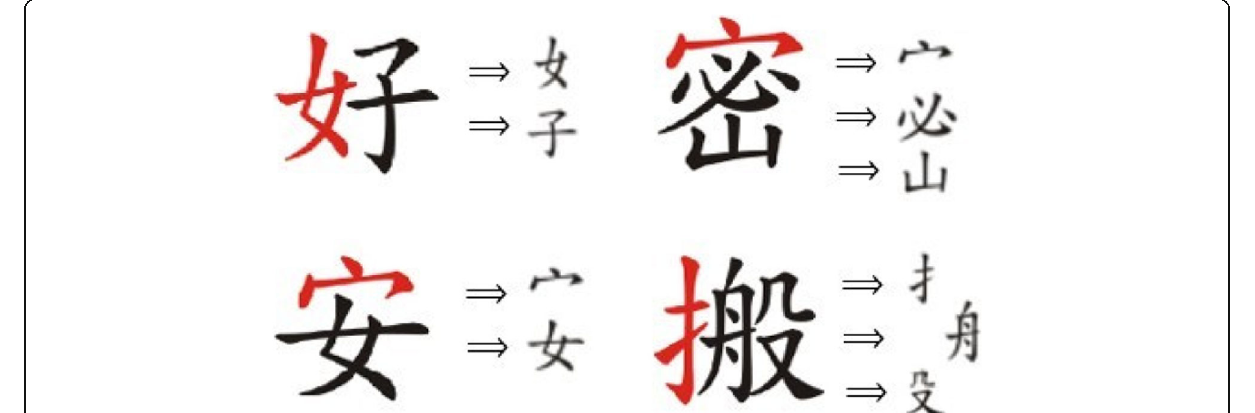
Fig. 1 Examples of Chinese character decomposition considered in this